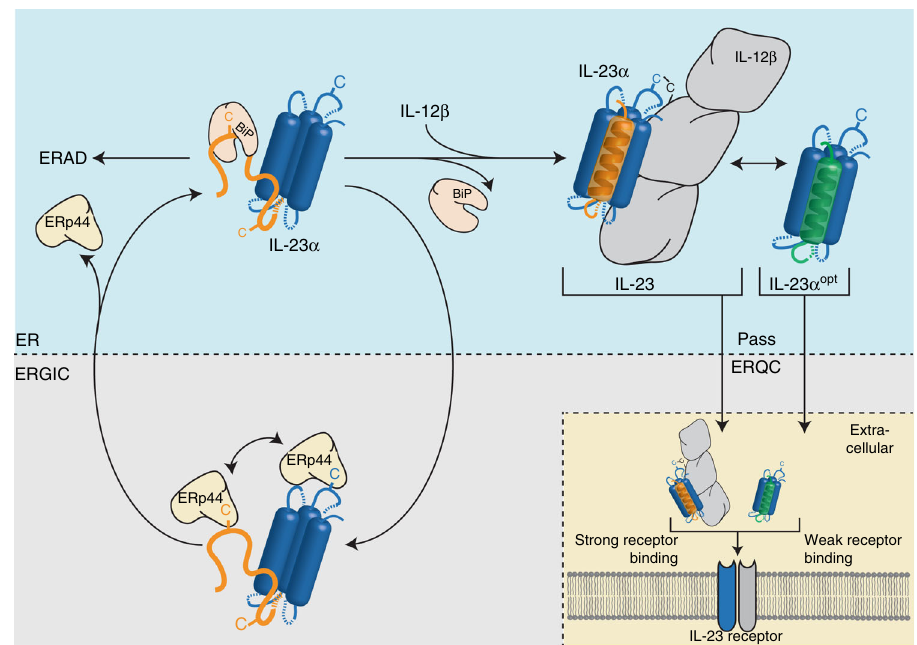
Fig. 5 A model for IL-23 assembly control in the cell. Incomplete folding of IL-23 α wt is recognized by chaperones along the secretory pathway. IL-23 α is incompletely structured in isolation, in particular the fi rst out of its four helices, and can be recognized by BiP during early biogenesis steps within the ER. ERp44, a member of the PDI-family, supports BiP function by retrieving IL-23 α from the ERGIC compartment to the ER, thus acting downstream of BiP. BiP and ERp44 act together, to maintain assembly competency of IL-23 α . Upon assembly with IL-12 β , IL-23 α completes folding of its fi rst helix, which inhibits chaperone interaction and results in secretion of the heterodimeric IL-23 complex, connected by a disul fi de bond. If IL-23 α does not assemble properly, it is targeted for ER-associated degradation (ERAD). ERAD is slowed down by the presence of free cysteines in IL-23 α , thus most likely by chaperone binding. Stabilization of the fi rst helix renders IL-23 α insensitive to chaperone interaction and allows independent folding and secretion. Despite independent secretion, IL-23 α opt is still able to interact with IL-12 β . IL-23 induces strong signaling upon receptor binding, whereas IL-23 α opt shows weak receptor activation. Loops within the structure of IL-23 α are indicated as dashed